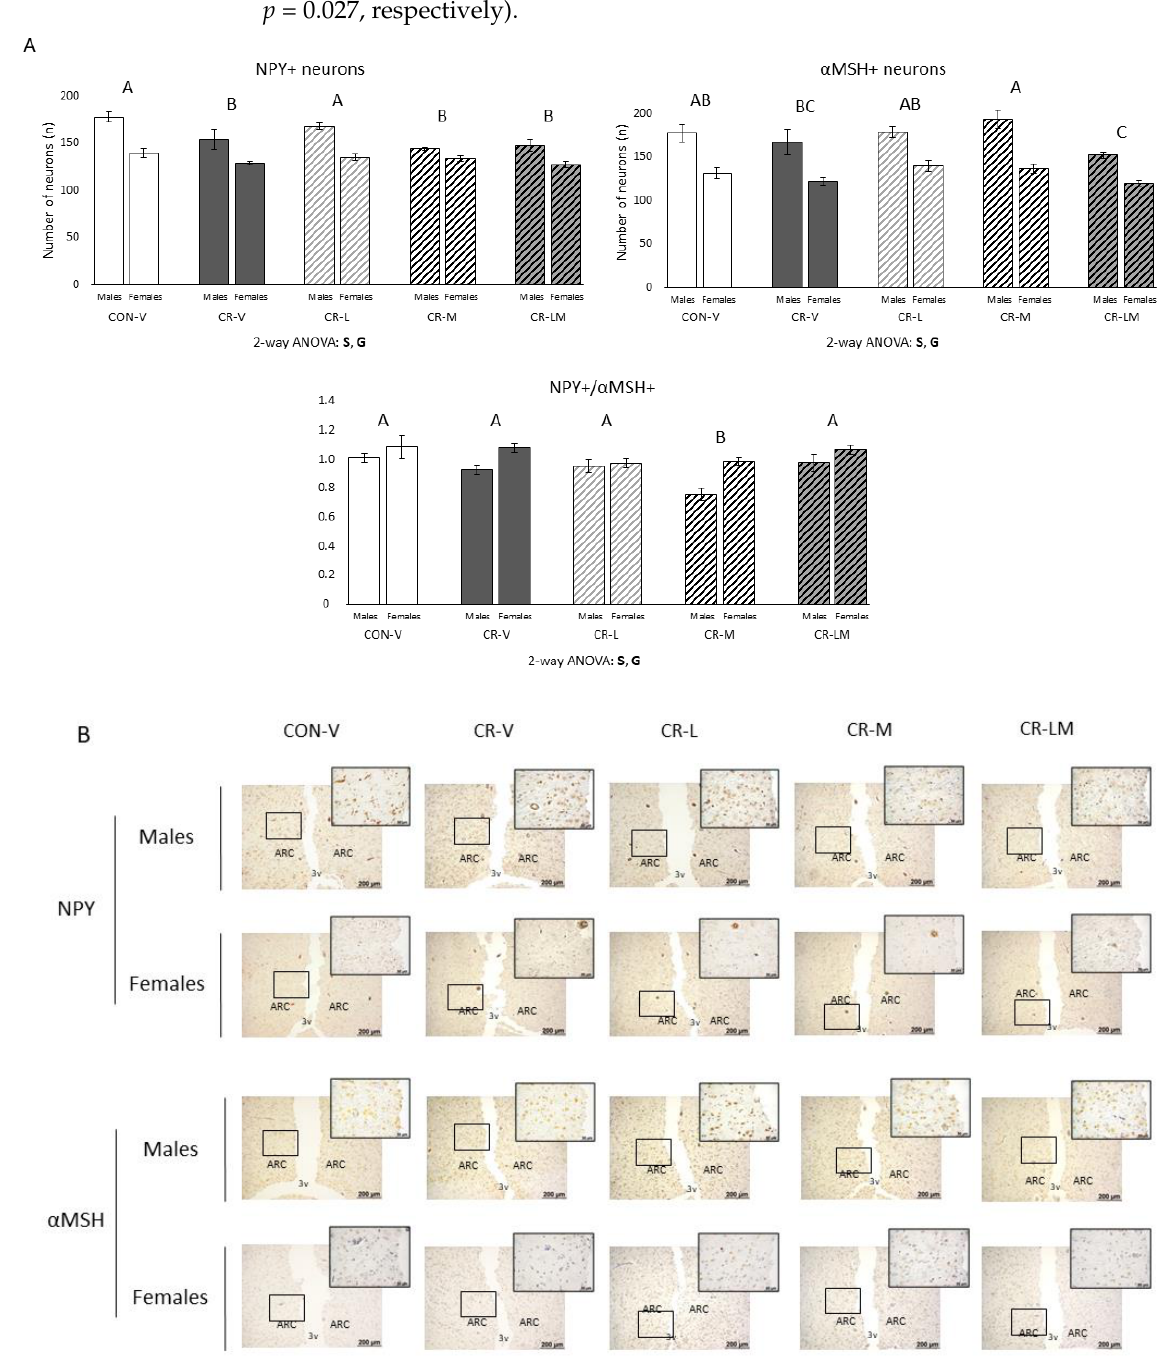
Figure 2. ( A ). Number of NPY and α MSH positive (NPY + and α MSH + ) neurons, together with NPY + / α MSH + ratio, in the arcuate nucleus (ARC) of the hypothalamus of 25-day-old male and female offspring of control (CON) and 25% gestational calorie-restricted (CR) dams. Data are means ± s.e.m ( n = 4–6). Statistics: Two-way ANOVA was performed to assess the effects of sex and group (CON-V, CR-V, CR-L, CR-M, and CR-LM), followed by a least significant difference (LSD) post-hoc test. Symbols: S, effect of sex; G, effect of group; A ≠ B ≠ C ( p < 0.05, two-way ANOVA). ( B ). Representative brain sections immunostained for NPY and α MSH. Insets: enlargement of the corresponding framed areas. Abbreviations: vehicle (V), leptin (L), myo-inositol (M), leptin and myo-inositol (LM), third ventricle (3v). Scale bar: 200 µ m and 50 µ m for